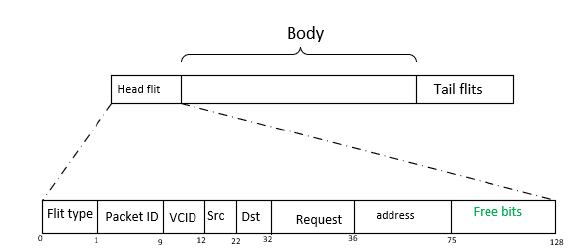
Fig. 4. Packet structure for 128-bit mesh based network